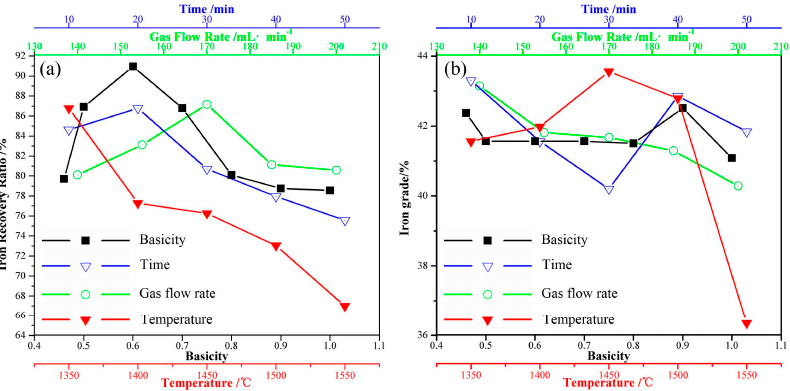
Figure 9. Effect of different factors on the iron recovery ( a ) and grade ( b ).